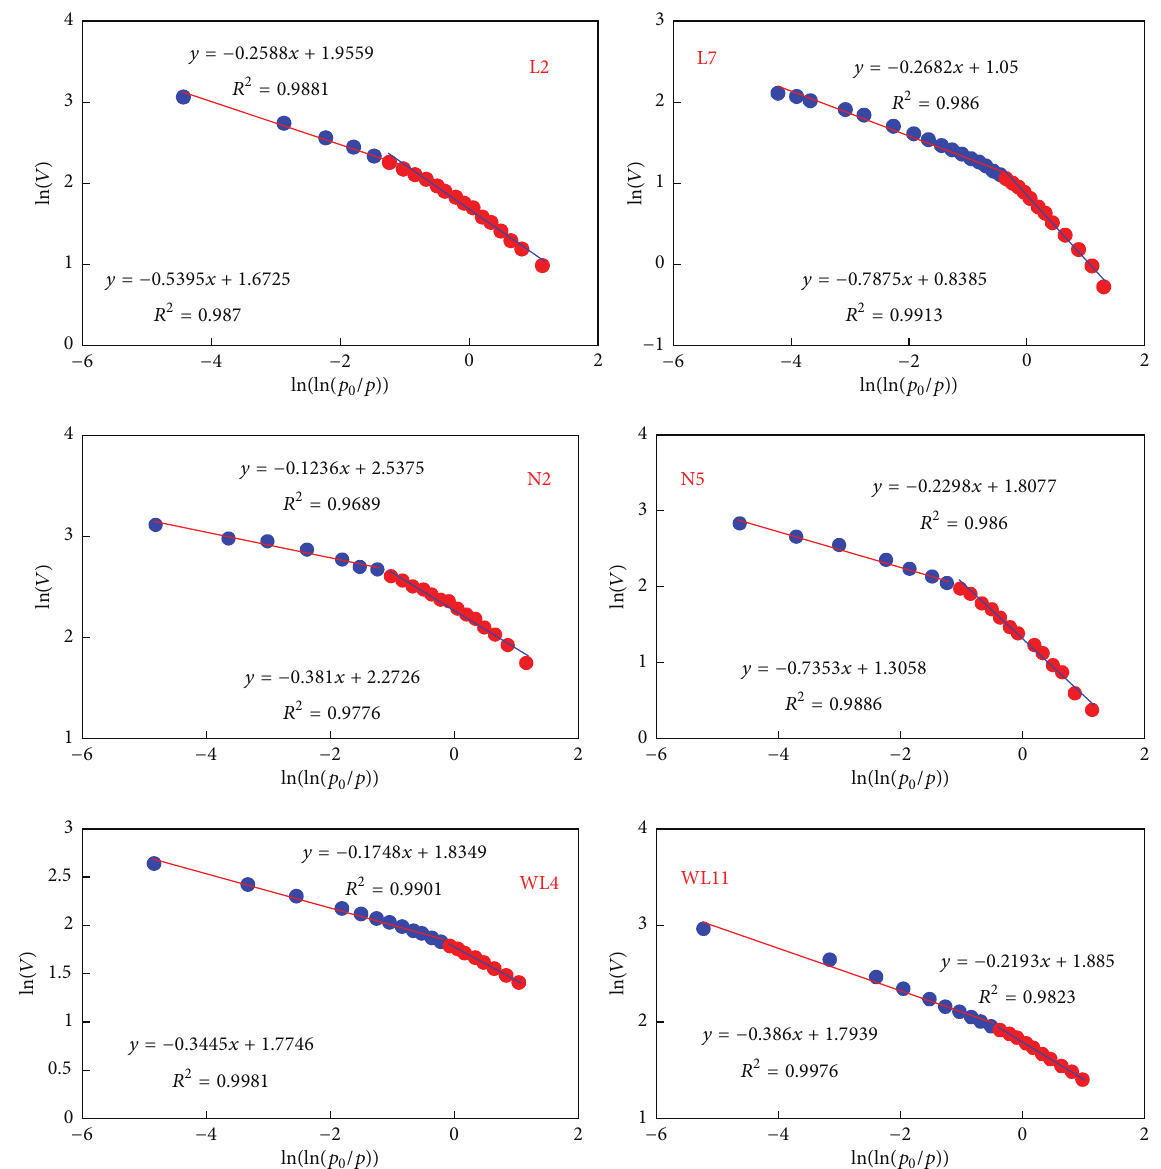
Figure 2: Plots of ln (𝑉) versus ln ( ln (𝑝 0 /𝑝)) reconstructed from the N 2 adsorption data of some shale